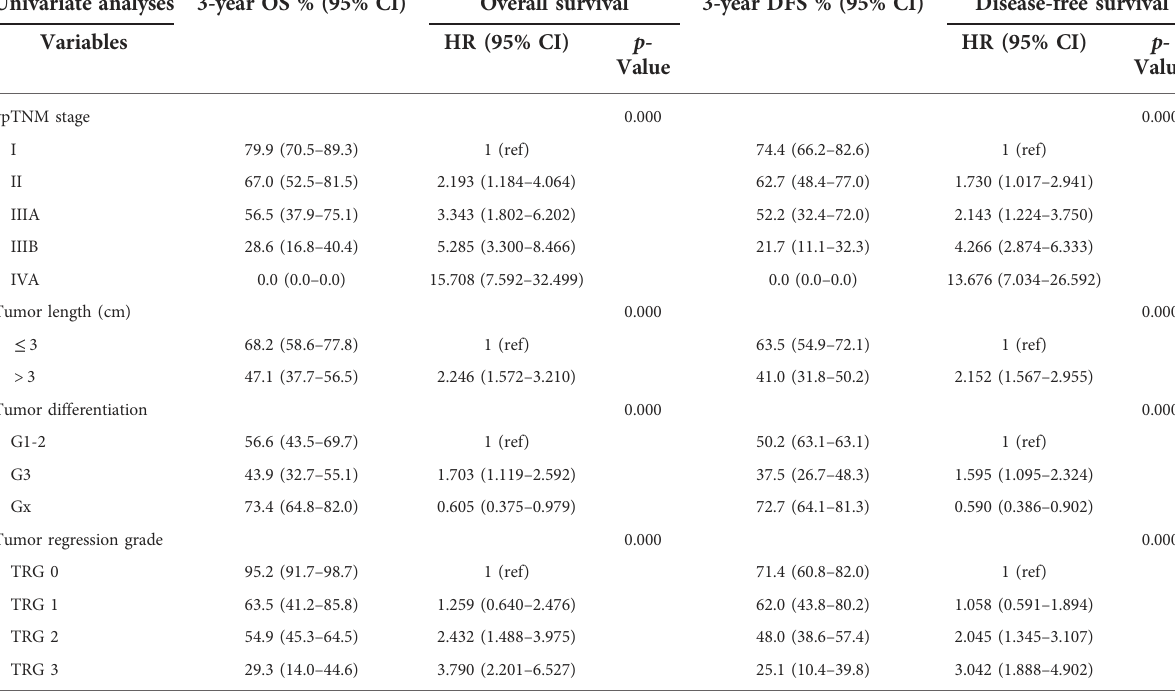
TABLE 3 Impact of treatment outcome and prognostic relevance on overall survival and disease-free survival.